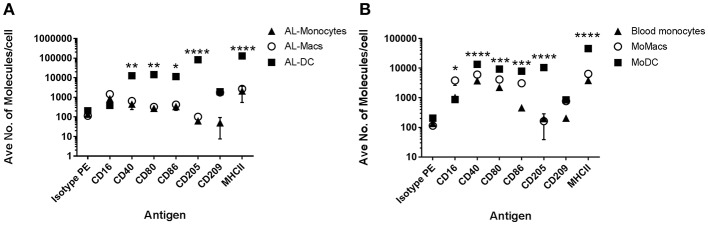
Quantification of surface molecules on bovine AL monocytes, ALDCs, ALMacs, peripheral blood monocytes, MoMacs, MoDCs. (A) Quantification of the average number of molecules on the surface of bovine AL monocytes (black triangles), ALMacs (white circles) and ALDCs (black squares). (B) Average number of molecules on the surface of bovine blood monocytes (black triangles), MoMacs (white circles), and MoDCs (black squares). Each symbol represents means calculated from cells obtained from 5 different animals analyzed in triplicate; error bars indicate standard error of the means. *p < 0.05, **p < 0.01, *** p < 0.001, and ****p < 0.0001.